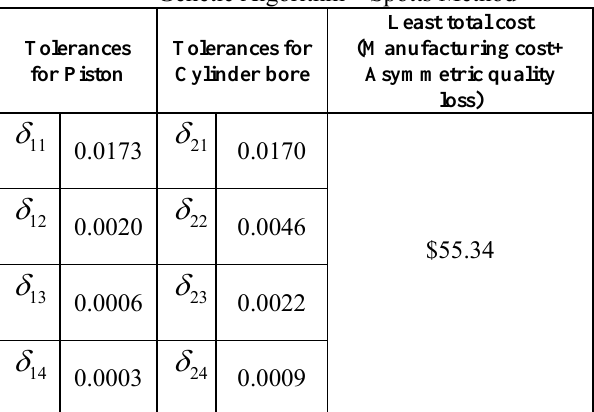
Table 4 Optimal tolerances allocated using